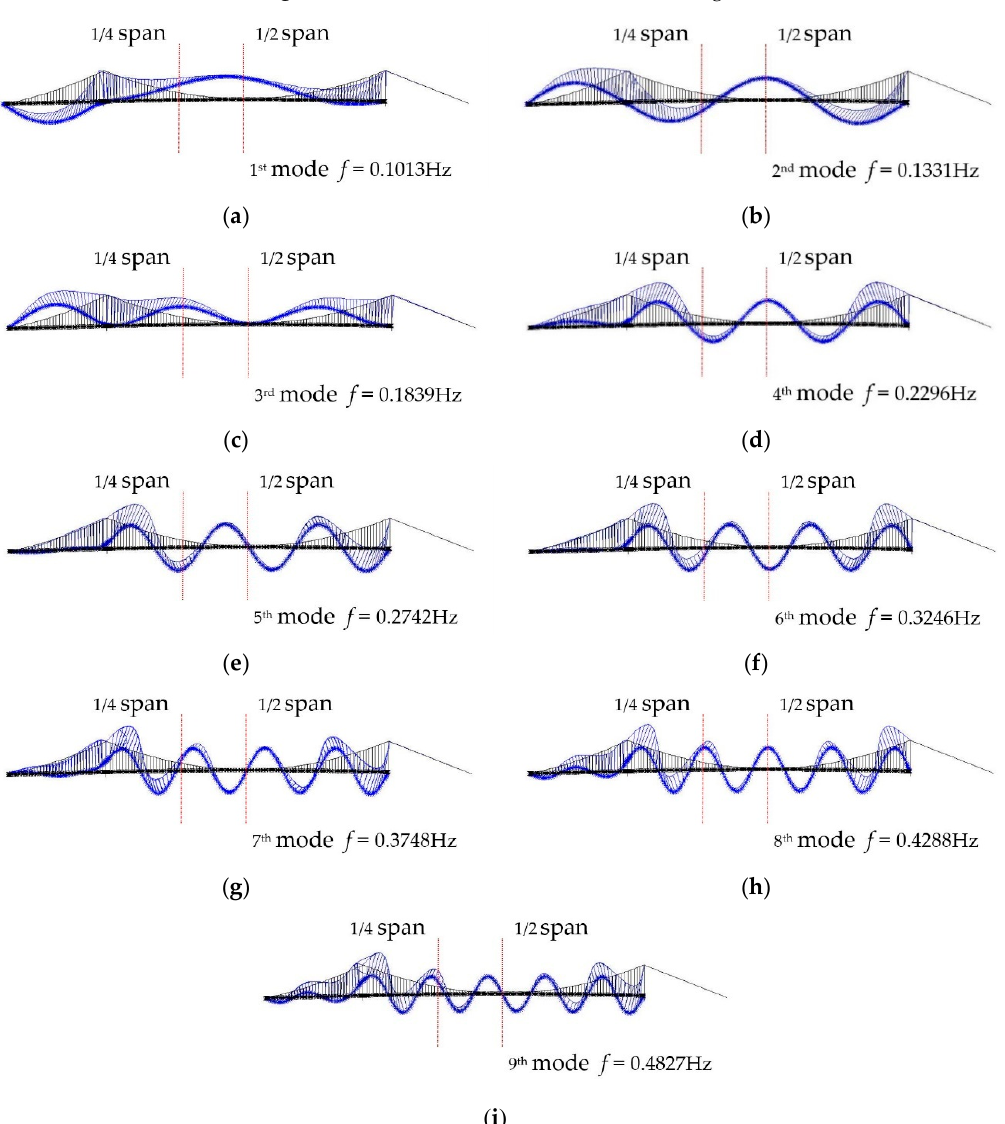
Figure 17. Main vertical modes for sti ff ening girder of XHM Bridge: ( a ) mode 1; ( b ) mode 2; ( c ) mode 3; ( d ) mode 4; ( e ) mode 5; ( f ) mode 6; ( g ) mode 7; ( h ) mode 8; ( i ) mode 9.